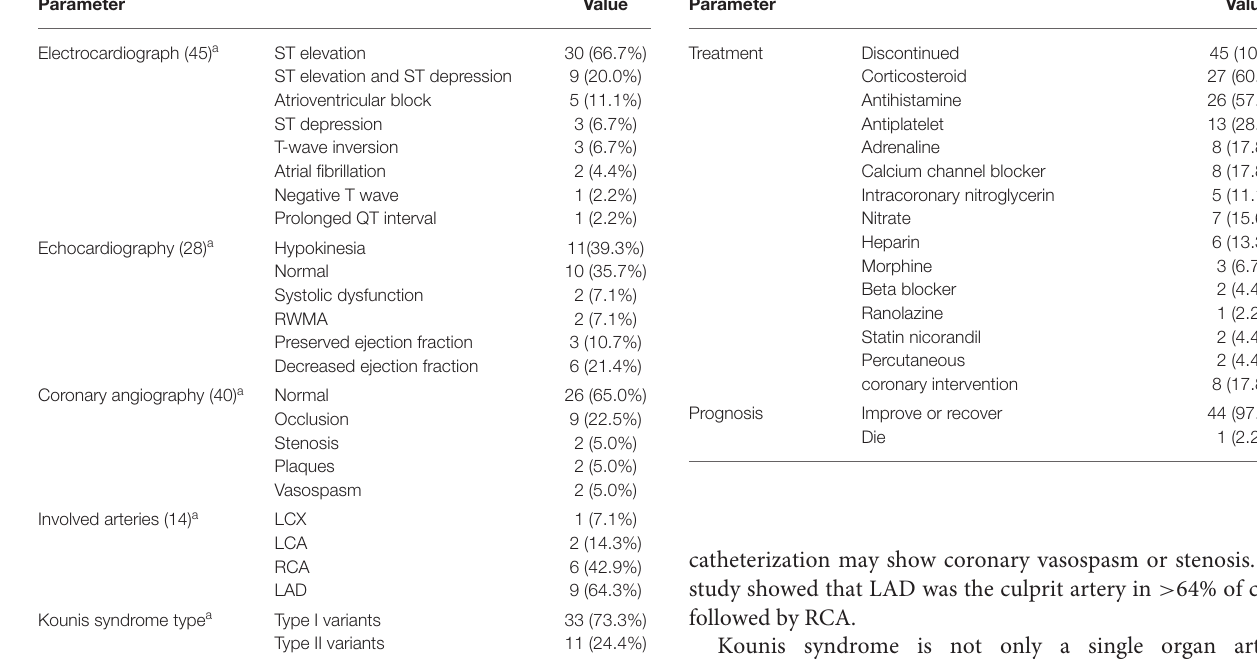
TABLE 3 | Imaging of NSAIDs-induced Kounis syndrome. Parameter